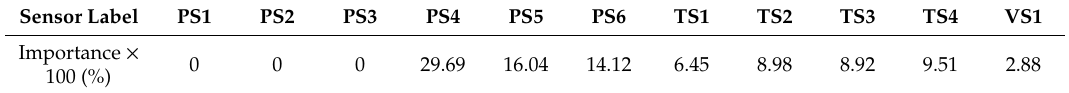
Table 4. Feature Importance Calculated for Each Sensor Feature.